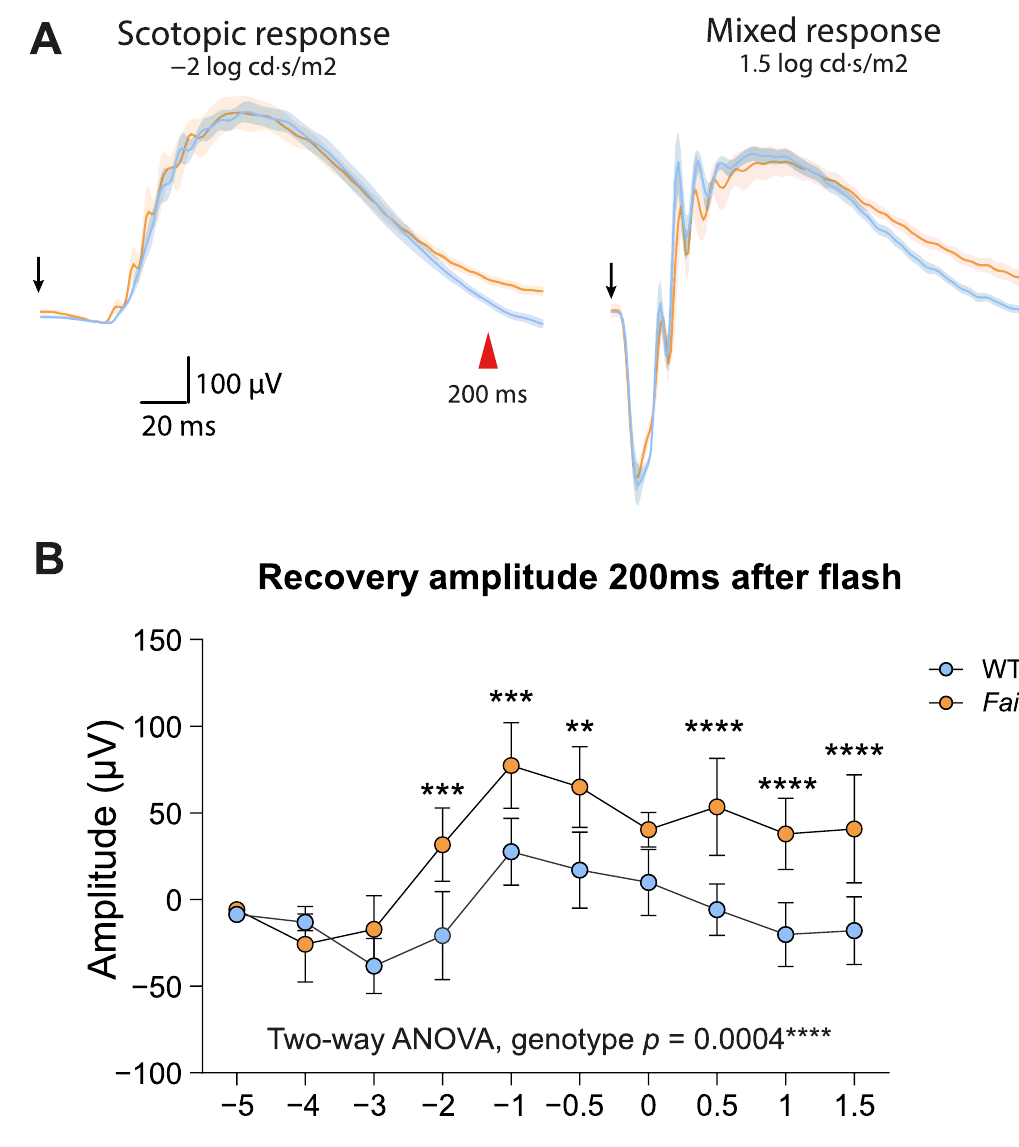
Figure 3. Faim KO mice present a delay in photoresponse deactivation at three months. ( A ) ERG recordings of scotopic and mixed responses ( − 2 and 1.5 log cd · s/m 2 , respectively) plotted as the mean (solid line) and SEM deviation (shaded area) of each condition. It can be observed how the recovery of the mixed response in the Faim KO animals is prolonged in time with respect to the WT mice. Black arrows indicate the stimulus flash. Red arrowheads indicate 200 ms timepoint. ( B ) Recovery amplitude of WT and Faim KO mice 200 ms after the flash was evoked. Two-way ANOVA and Sidak’s post-hoc tests were performed. ** p < 0.01, *** p < 0.005, **** p < 0.001 ( n = 8–9 mice per genotype).